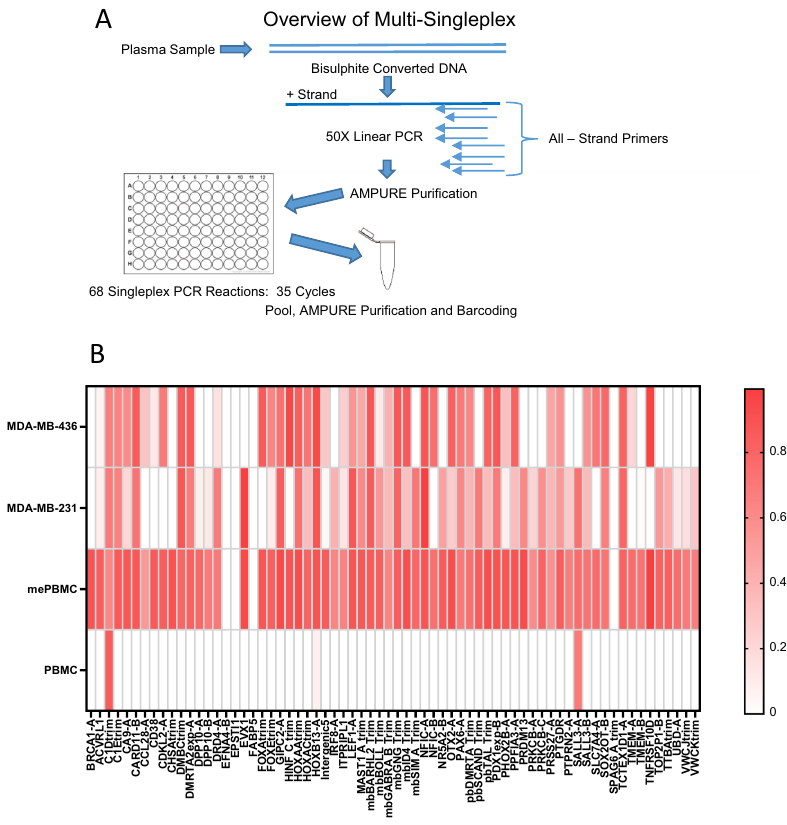
Fig. 5 Multi-Singleplex approach. A Samples were linear ampli fi ed using all 68 negative strand primers for 50 cycles. After puri fi cation the sample was split into 68 separate PCR reactions with each probe. The products were then pooled and barcoded. B A heatmap of the fraction methylated DNA for each probe. Two TNBC cell lines (MDA-MB-436 and 231), normal PBMC DNA and PBMC synthetically methylated (mePBMC) were analysed. For each probe the number of reads methylated at all CpGs positions between the primers was divided by the total number of reads to give the fraction of methylation for each with the shading representing this fraction from 0 to